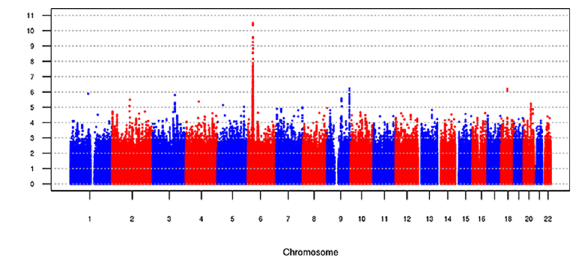
Fig 1. Manhattan plot for genome-wide association for ln(sRAGE) in whites (N = 1,737).